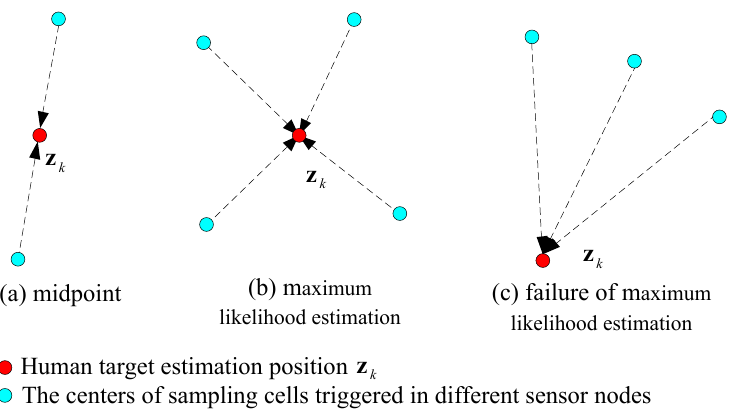
Figure 9. Data fusion strategy of adjacent sensor